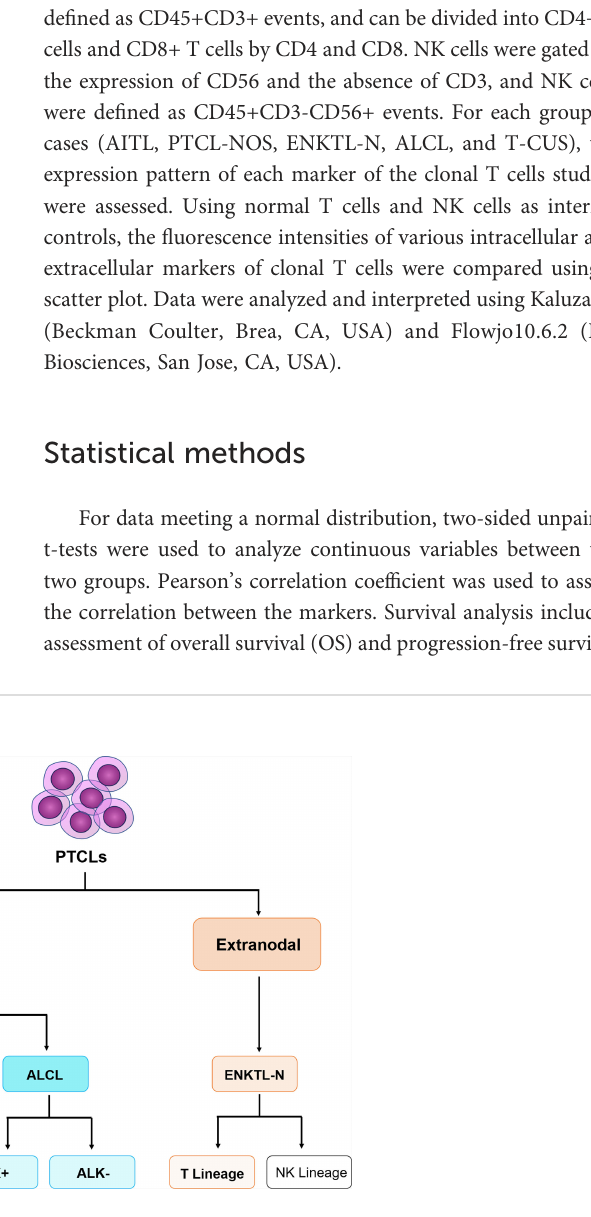
FIGURE 1 The classi fi cation of peripheral T-cell lymphomas follows the World Health Organization 2017 classi fi cation of lymphomas. PTCLs, Peripheral T- cell lymphomas. TFH, follicular helper T-cell; ALK, anaplastic lymphoma kinase; AITL, angioimmunoblastic T-cell lymphoma; PTCL-TFH, follicular helper T-cell lymphoma; PTCL-NOS, peripheral T-cell lymphoma tumor, unspeci fi ed; ALCL, anaplastic large cell lymphoma; ENKTL-N, extranodal NKT cell lymphoma. (Only the types included in this study are limited